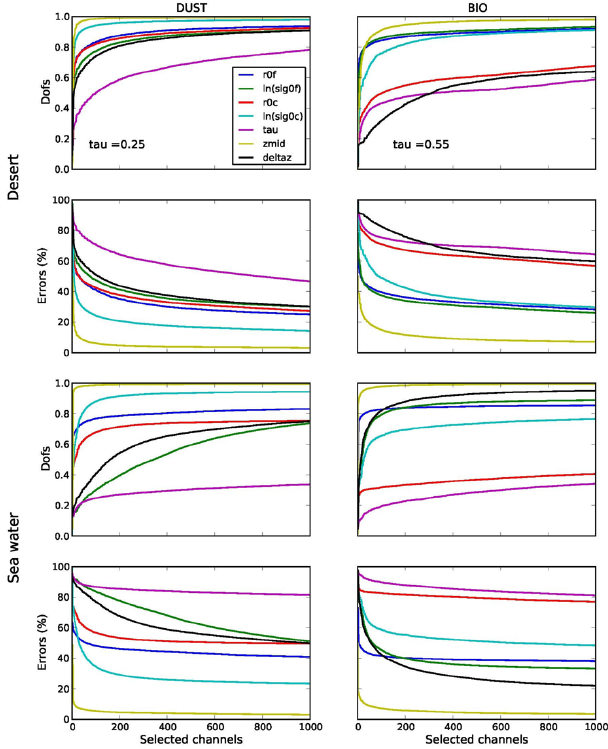
Fig. 4. DOFSs and total error (in %) for each aerosol parameter of the state vector vs. number of selected